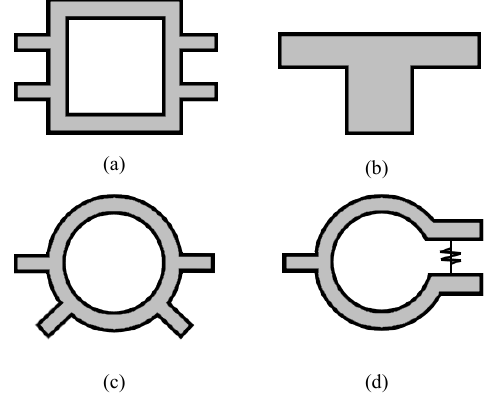
Figure 10. Power dividers. (a) Quadrature hybrid. (b) T-junction. (c) Ring hybrid. (d)